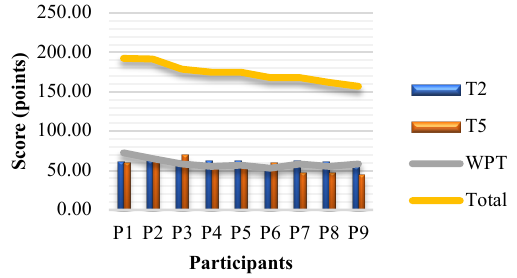
Figure 8. Results of the psychological selection stream